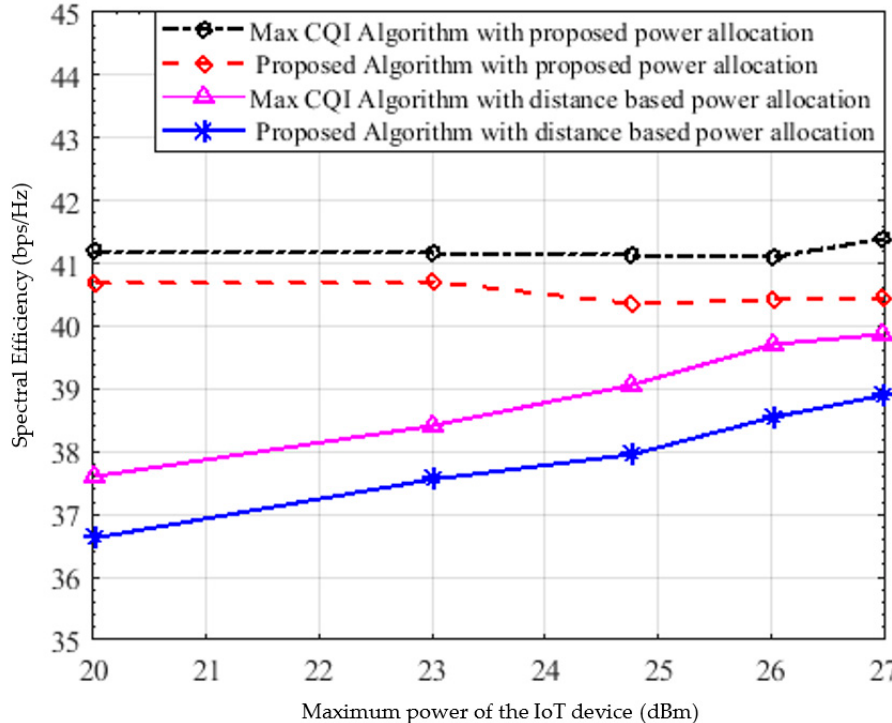
Figure 10. Spectral efficiency versus the power of the IoT devices.